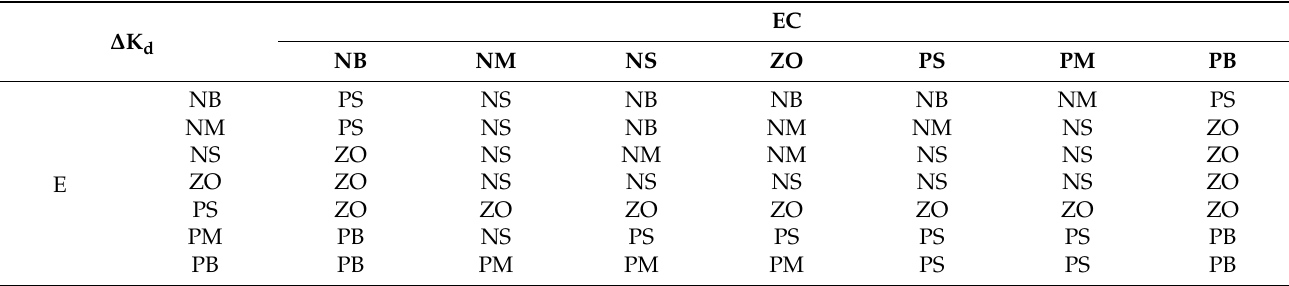
Table 4. Rule of Fuzzy-PID control of ∆ K d